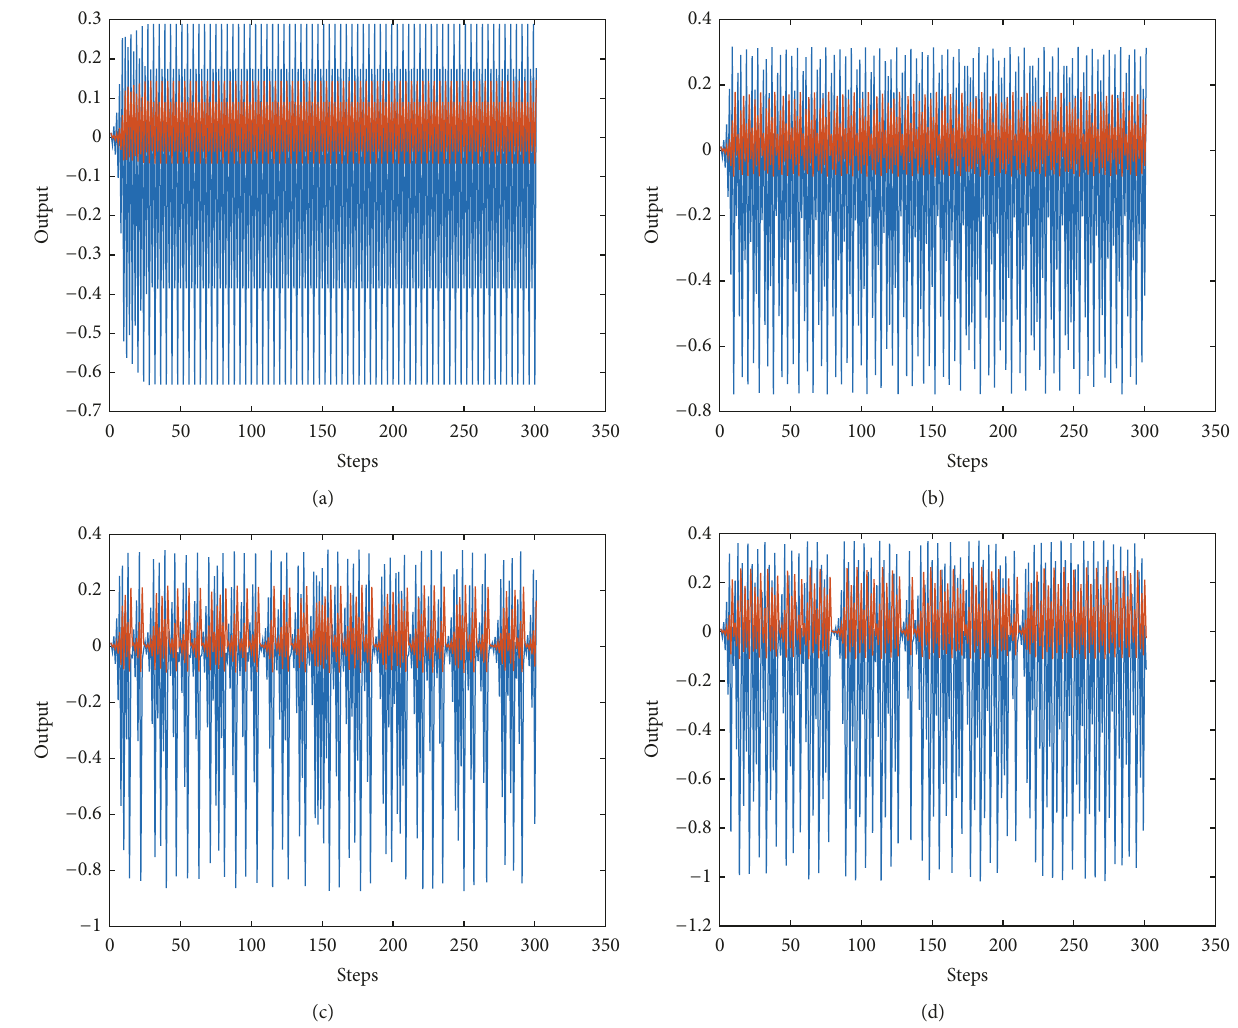
Figure 7: The changes of the output with antichaos control item (a) 𝑘 = 0.3 ; (b) 𝑘 = 0.35 ; (c) 𝑘 = 0.4 ; (d) 𝑘 = 0.45 .